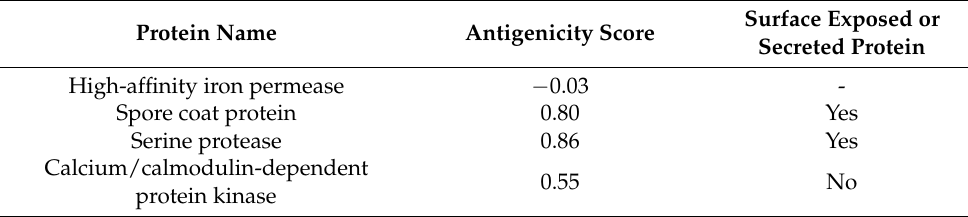
Table 1. Antigenicity and cellular localization of virulent proteins in Rhizopus microsporus .